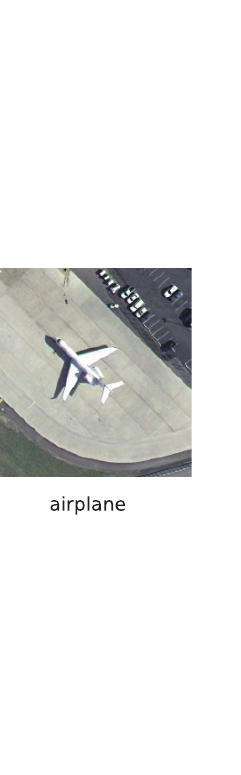
Figure 16. An example of an energy map for feature maps P 2 – P 5 .